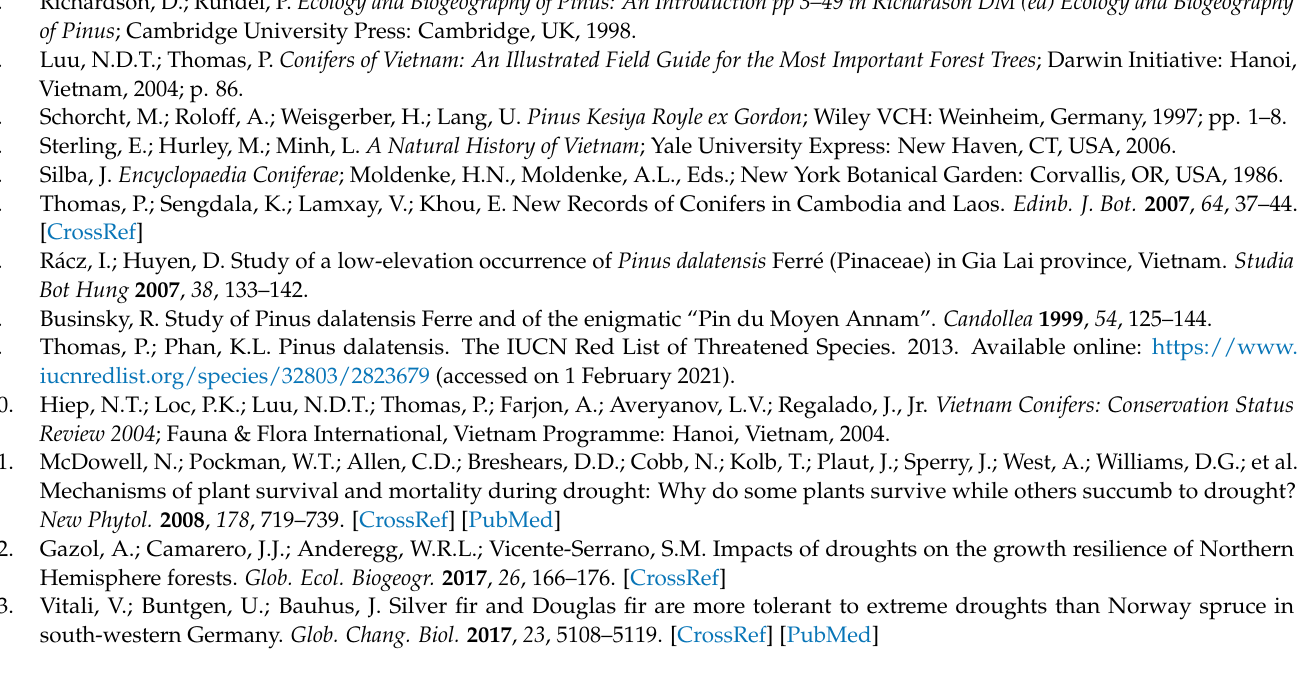
Figure S2: Correlation coefficients of 13 C discrimination against atmospheric CO 2 ( ∆ 13 C) of the two pine species with temperature ( black bars ) and precipitation ( grey bars ) from 1901 to 2013. Dotted lines indicate thresholds of significance at p < 0.05. The letters on the x -axis indicate calendar months and seasonal periods. Table S1: Soil chemical properties of the plots with different Pinus species. PIKE : Pinus kesiya ; PIDA : Pinus dalatensis